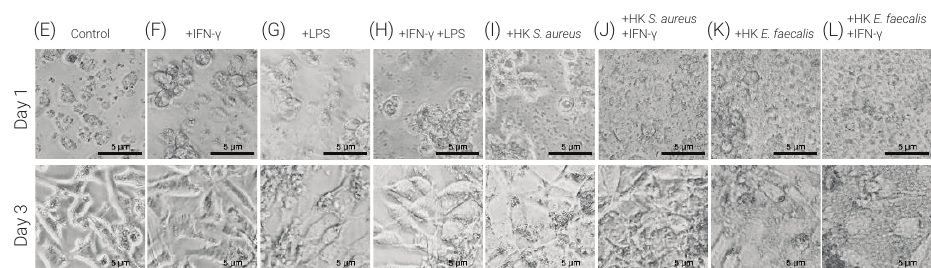
Figure 2. L929 cell viability. Graphs represent cell cultures with different concentrations (10 5 -10 8 CFU. mL -1 ) of HK- S. aureus antigen (A) with rIFN-γ (C) or HK- E. faecalis antigen (B) with rIFN-γ (D), after 72h of cell incubation. Bars represent mean and standard error of cellular absorbance (595 nm) carried out in technical and biological triplicates. Statistical differences by one-way ANOVA test and Bonferroni post hoc were represented by * (p < 0.05). Optical microscopy (20x) shows the initial (day 1) and final (day 3) cell morphology aspects (E-K) of L929 stimulated with rIFN-γ (F), LPS (G), LPS and rIFN-γ (H), HK- S. aureus 10 6 CFUs without (I) or with rIFN-γ (J), HK- E. faecalis 10 6 CFUs without (K) or with rIFN-γ (L) compared to the cell control group